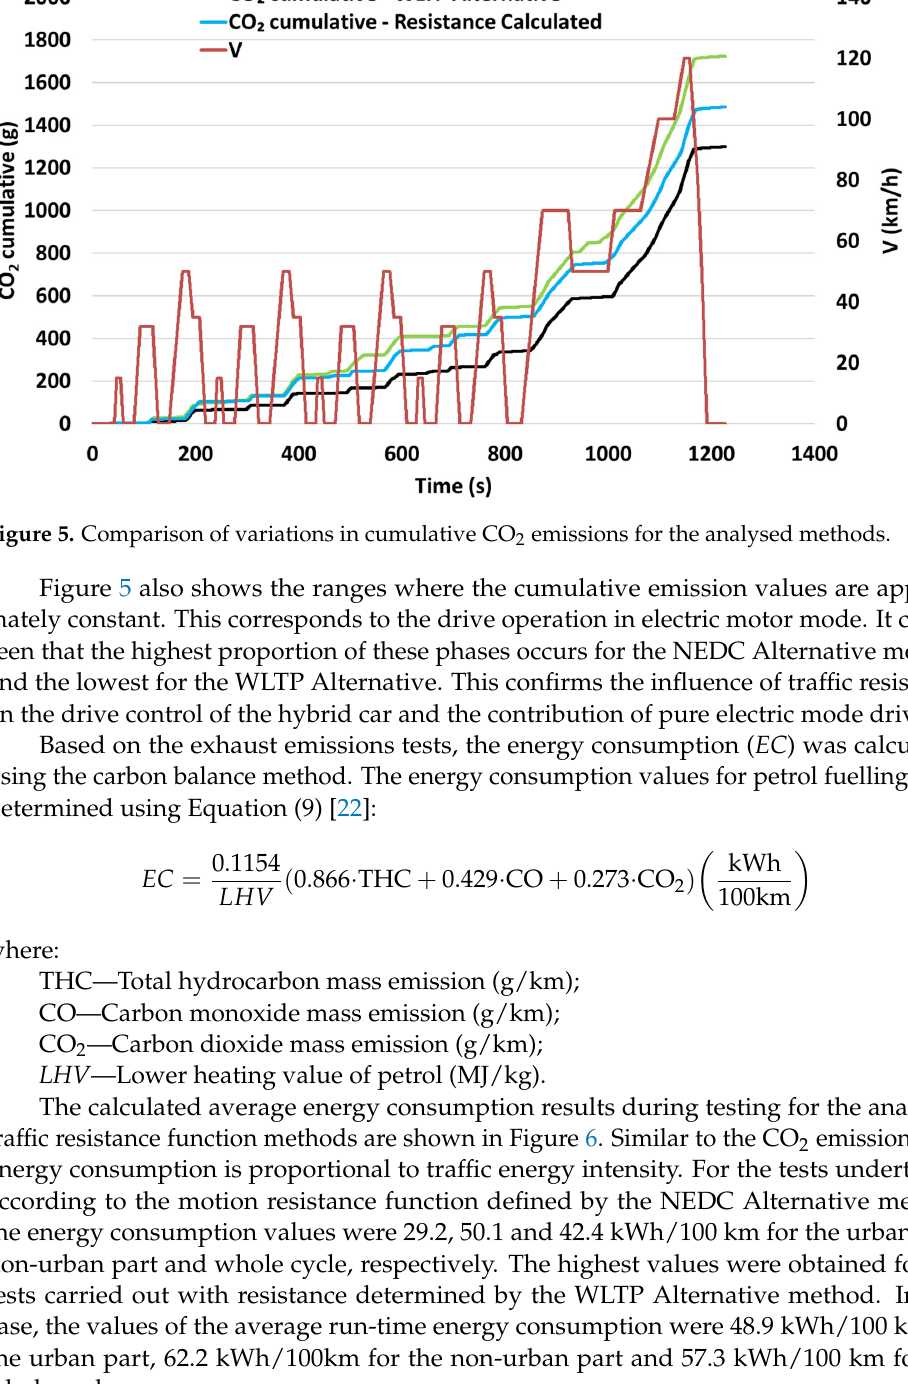
Figure 4. Dependence of velocity and CO 2 emissions as a function of time for the analysed dyna- mometer load setting methods: ( a ) NEDC alternative, ( b ) resistance calculated and ( c ) WLTP alter- native.